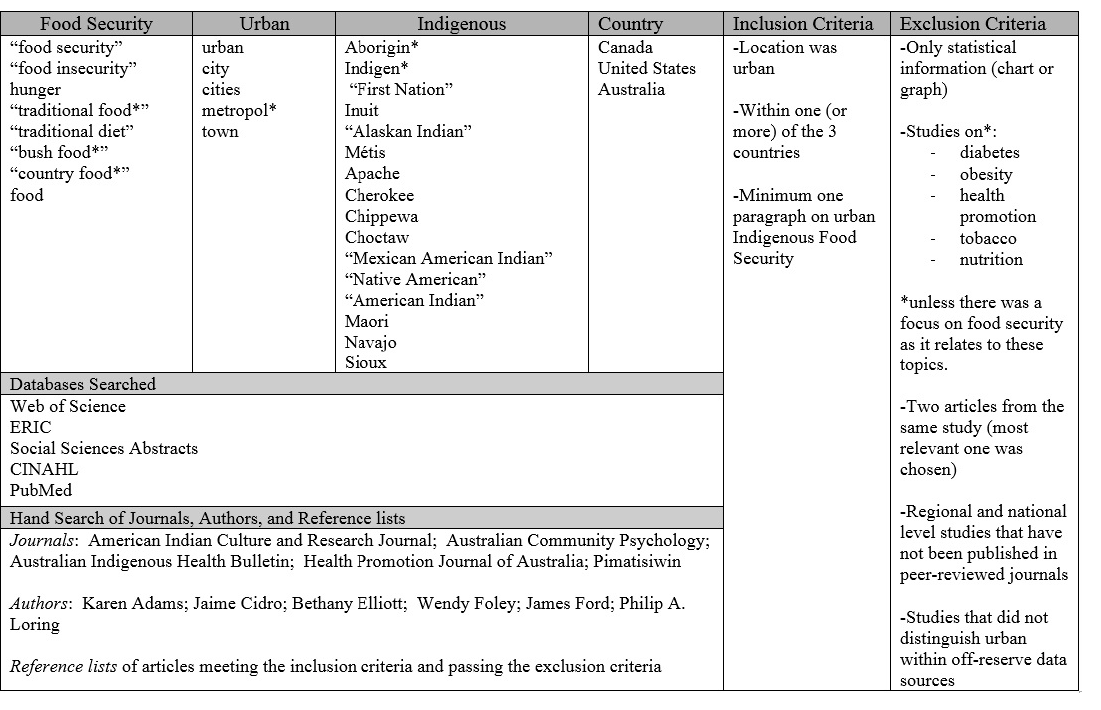
Figure 1. Search protocol and inclusion and exclusion criteria.